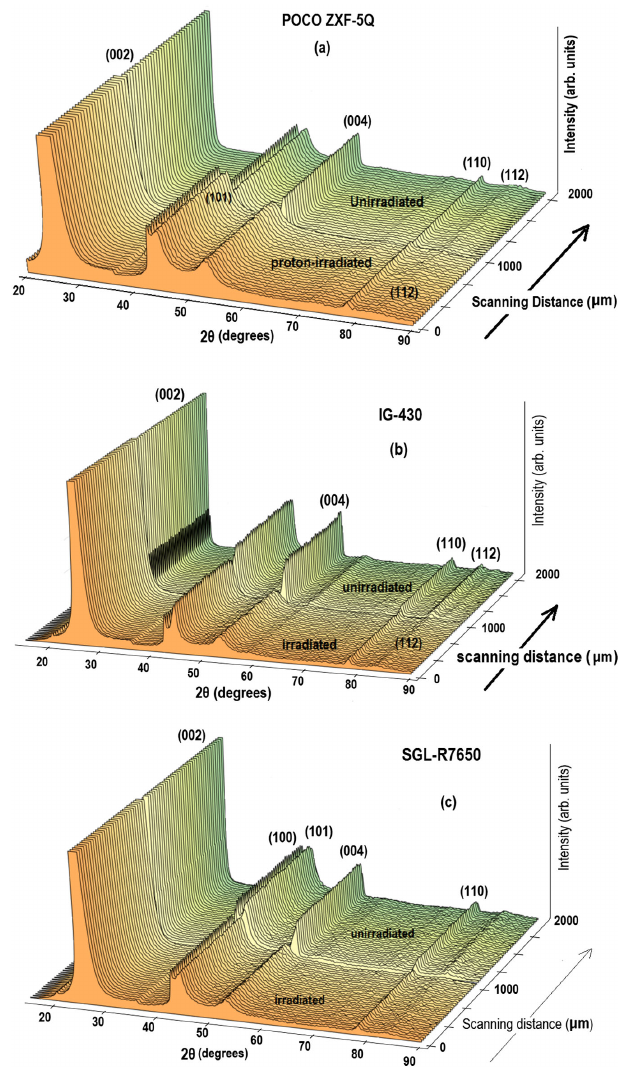
FIG. 17. 3D X-ray phase map of proton-irradiated (a) POCO, (b) IG 430 and (c) SGL graphite grades for proton fluence of 5 . 66 × 10 20 p = cm 2 . (002) diffraction peak is truncated for